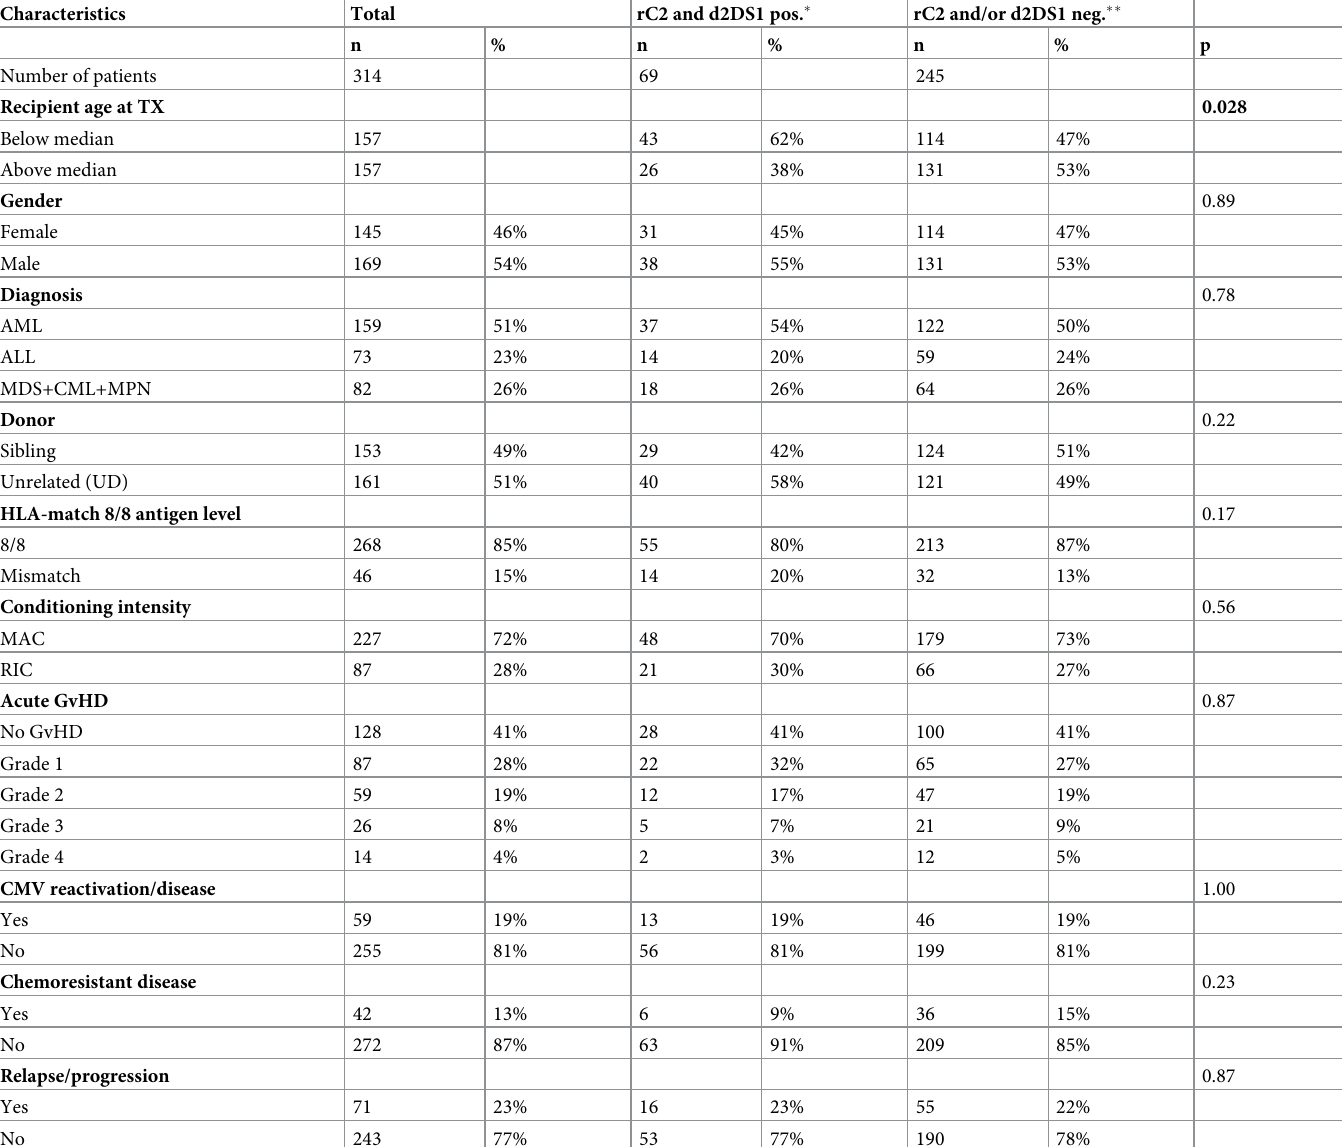
Table 1. Basic demographic, disease and intervention related characteristics as well as presence or absence of key outcome parameters for the entire cohort and for subgroups according to the simultaneous presence of recipient HLA-C2 group alleles (rC2) and donor KIR2DS1 (d2DS1) gene. Characteristics Total